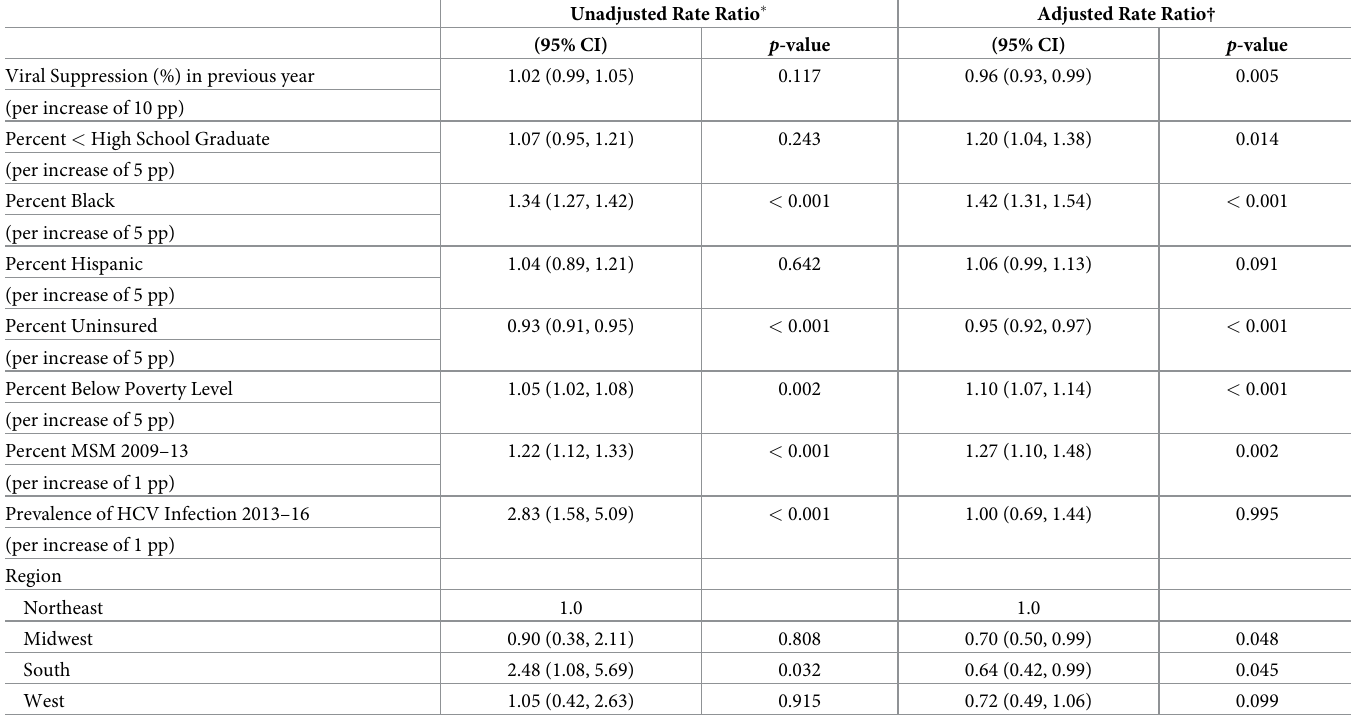
Table 3. Unadjusted and adjusted associations of estimated HIV incidence rate with state level viral suppression and demographic variables.